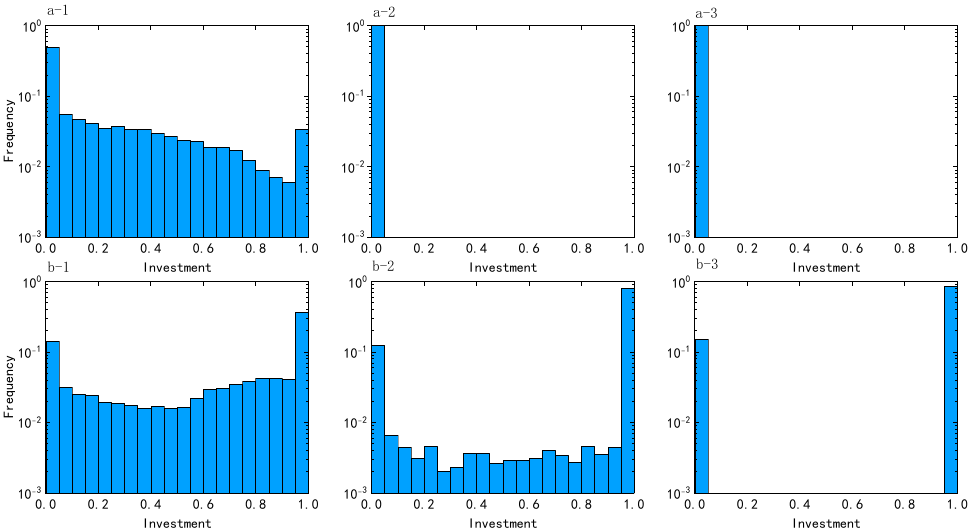
Figure 10. Comparisons of the distribution of strategy values for different combinations of 𝑟 and 𝛼 : ( a ) at 𝑟 = 2.0 ; ( b ) at 𝑟 = 4.0 . ( 1 ) 𝜔 = 0.8 , 𝛼 = infinite; ( 2 ) 𝜔 = 0.8 , 𝛼 = 4 ; ( 3 ) 𝜔 = 0.8 , 𝛼 = 1 . Data were obtained at time-step 50,000.